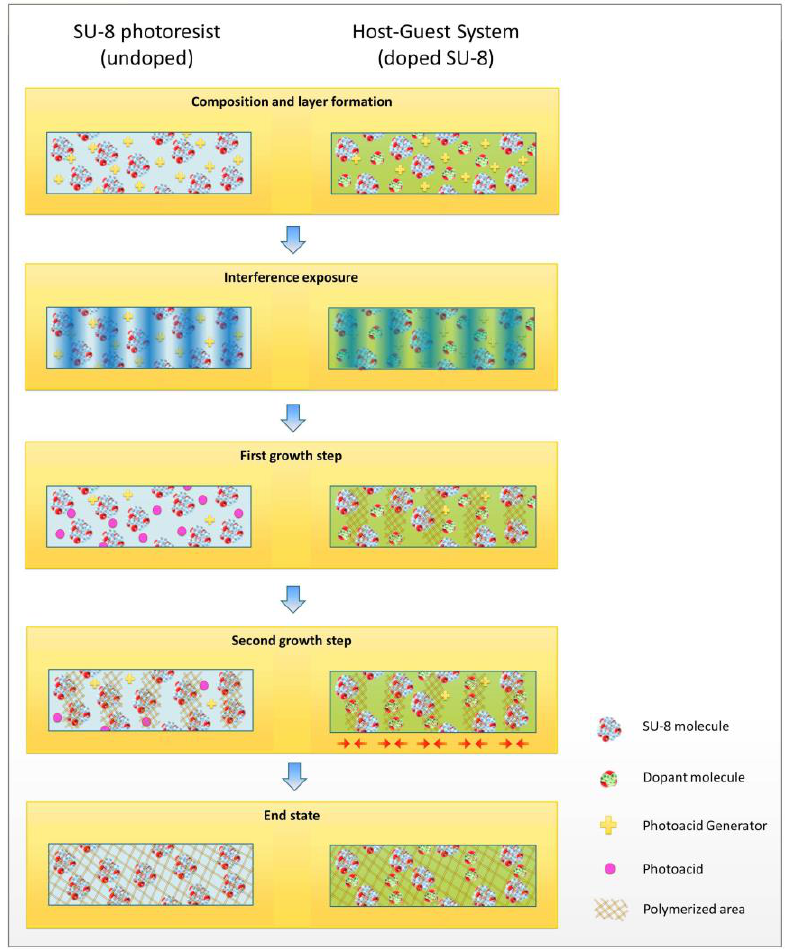
Figure 8. Graphical representation of grating growth in the doped and undoped system, respectively. The material composition is schematically displayed in the top line. Below, holographic interference exposure is shown. The first growth step in the undoped system is attributed to photoacid generation. Local polymerization causes the first growth in case of the doped system and the second growth step in case of the undoped system. The second growth step in the doped system can be attributed to monomer diffusion. The final state is a completely polymerized system in both cases, while the diffusion of dopant molecules has induced a permanent grating in case of the doped system.